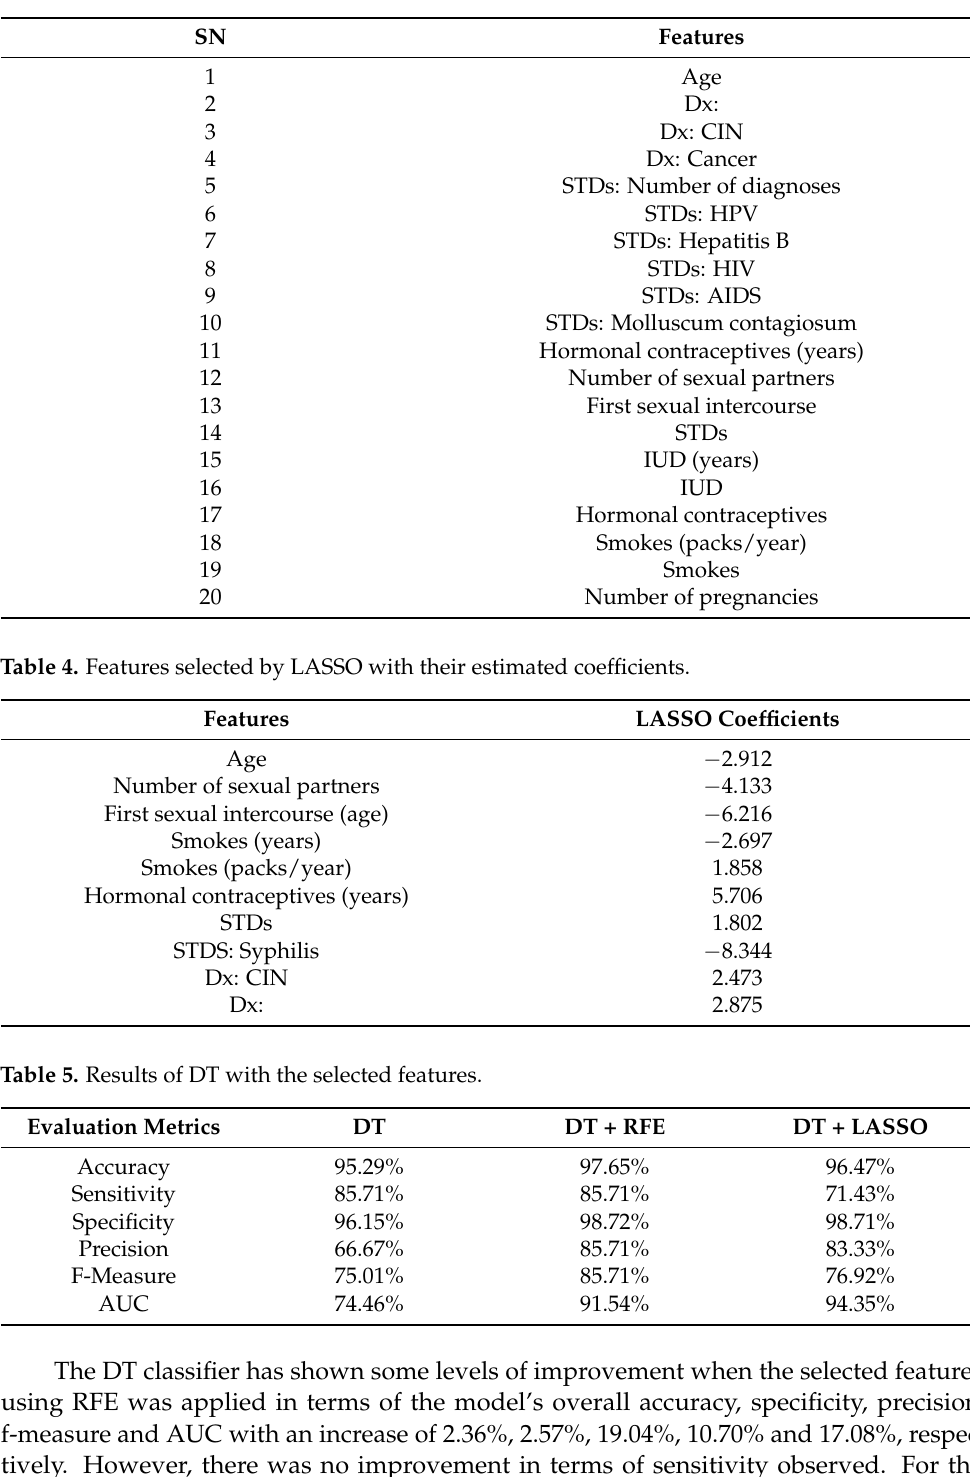
Table 3. Top ranked features in RFE.